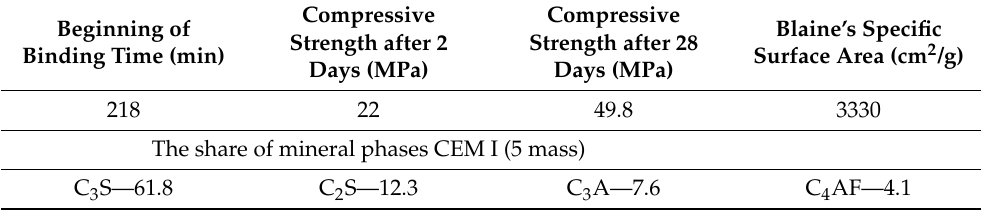
Table 2. Physical properties and phase composition of cement CEM I 42.5R.